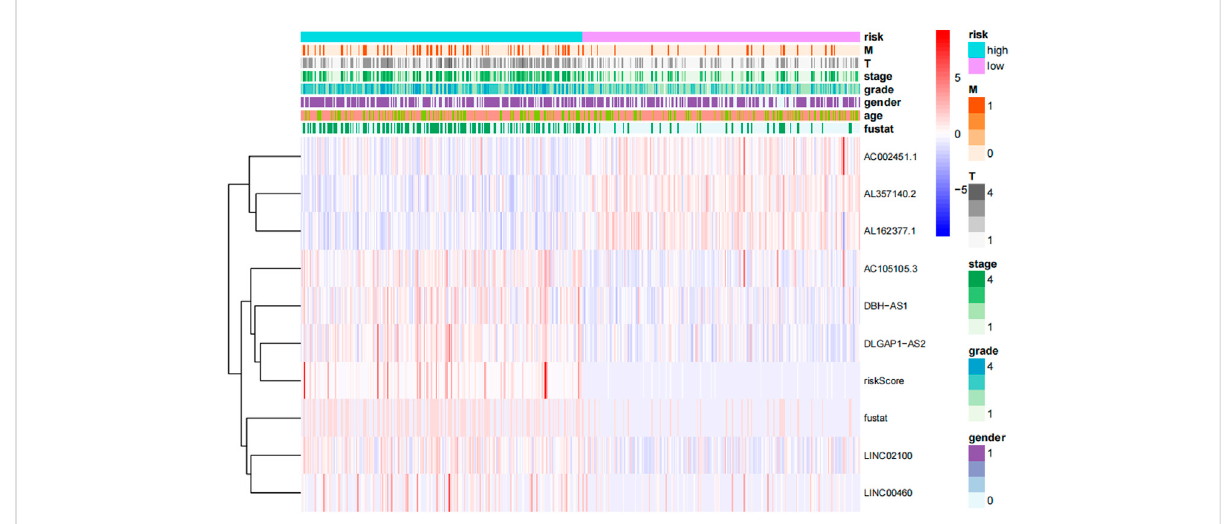
FIGURE 5 Heat map of the distribution of eight prognosis-related lncrna and clinicopathological variables in the high-risk and low-risk groups. lncRNAs, long-chain non-coding RNAs; M, metastasis; T, tumor.